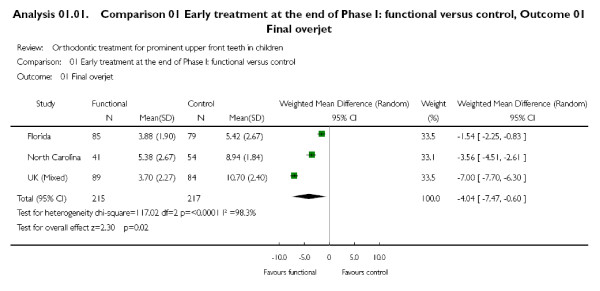
Example of extreme heterogeneity [20].